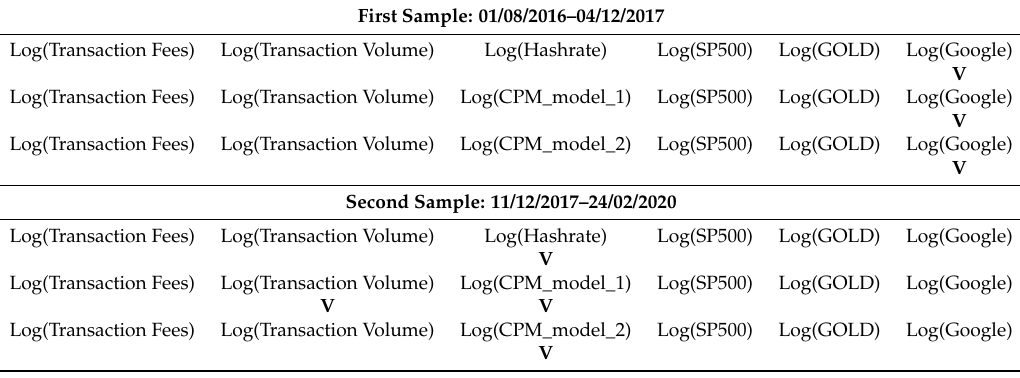
Table 6. Weak exogeneity tests: variables for which the null hypothesis of weak exogeneity can be rejected after re-testing at the 5% probability level.